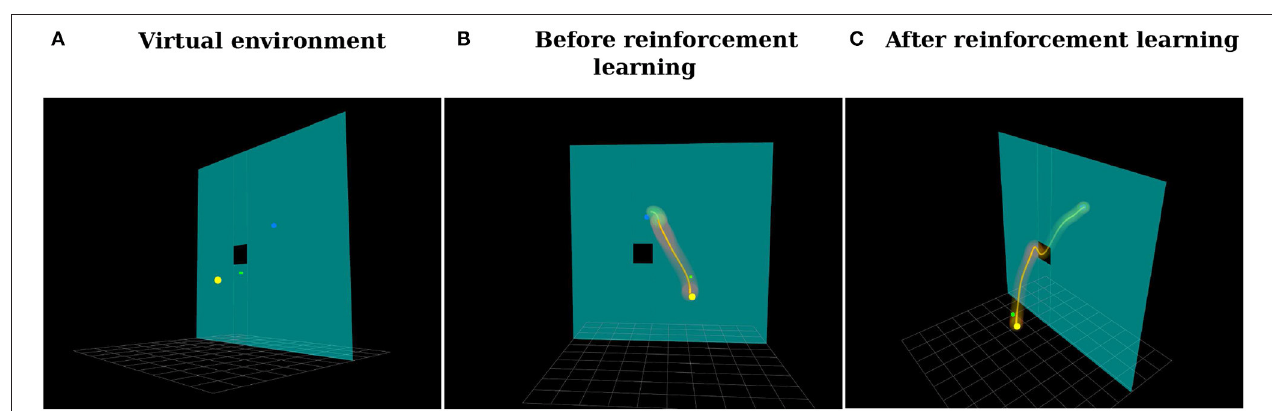
FIGURE 14 | (A) Virtual environment. The goal of the user is to teleoperate the green cube to move it from the position marked by the yellow sphere to the position marked by the blue sphere through the window to not hit the wall. (B) Distribution over trajectories before reinforcement learning. (C) Distribution over trajectories after reinforcement learning using the proposed Relevance Weighted Policy Optimization (RWPO)